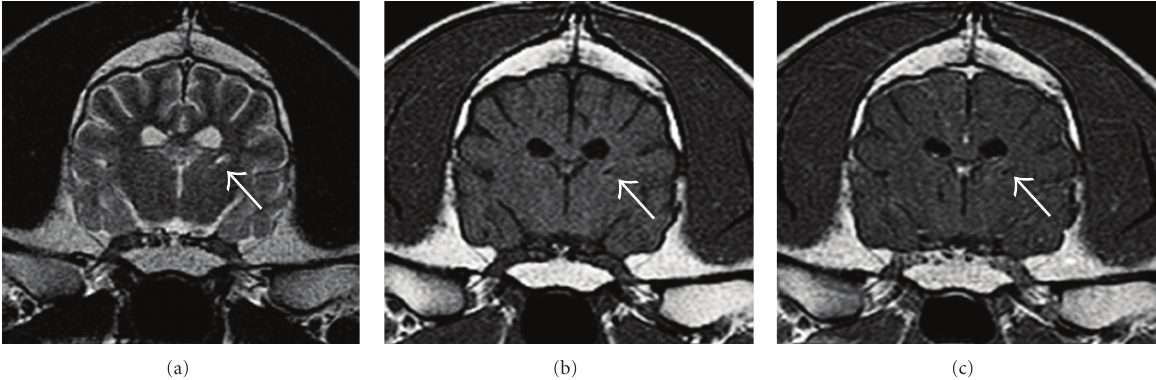
Figure 2: T2-weighted (a) TR = 3500, TE = 90), T1-weighted precontrast (b) TR = 588, TE = 15), and T1-weighted postcontrast (c) TR = 588, TE = 15) transverse plane images at the level of the thalamus in a dog with monocytic ehrlichial meningoencephalitis. A punctate T2 hyperintense lesion in the left dorsal aspect of the thalamus corresponds to a small cavitated region seen on T1-weighted images (white arrows). There is very subtle T1 hyperintensity of brain surrounding the cavitated region. There is little or no contrast enhancement of this